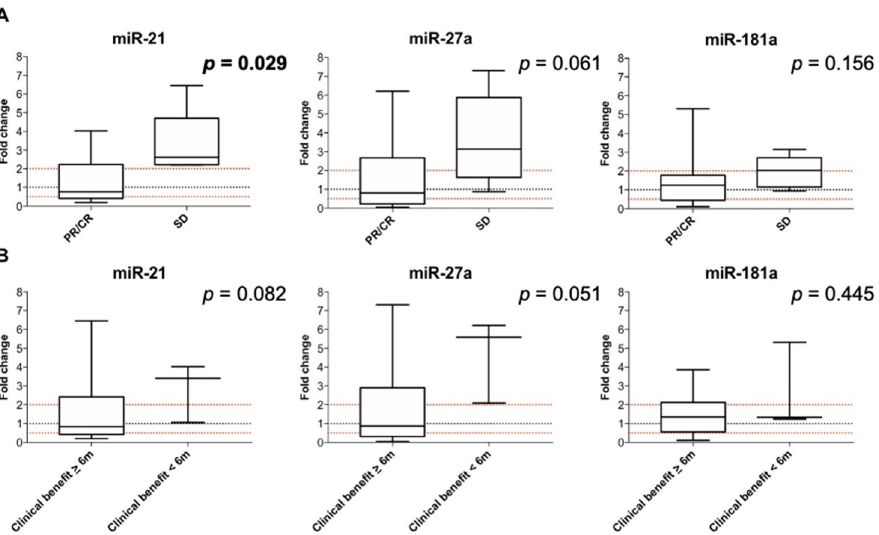
Figure 3. Modulation of miRNA expression at t1 and correlation with EGFR-TKI response ( A ) and duration of clinical benefit ( B ). Significant p values are in bold. The box plot represents the upper to lower quartiles, the whiskers are the minimum and maximum values, and the black lines represent the median values.